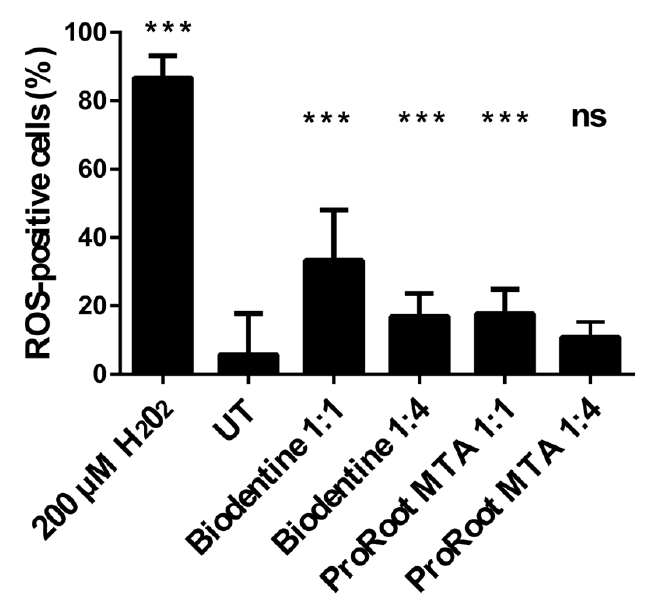
Figure 3. Intracellular ROS production of Saos-2 cells’ growth or not (UT) with different dilutions of extract for 72 h. Data are expressed as mean ± SD. Statistical analysis was performed by the one-way analysis of variance (ANOVA) method coupled with the Bonferroni post-test. (*** p < 0.001 compared to the untreated sample (UT); ns: not significant).